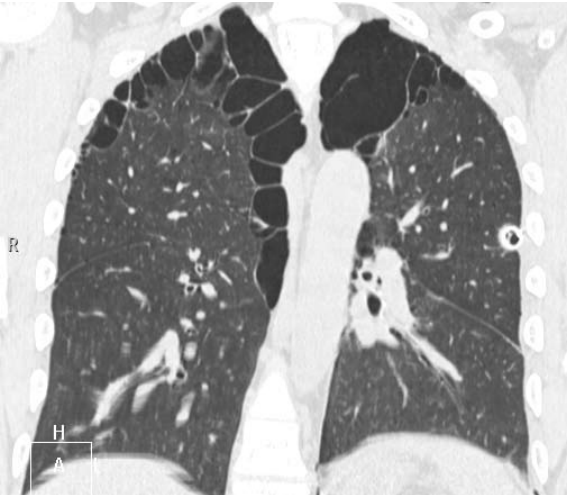
Fig. 1. Coronal reconstruction of the lung parenchyma on lung windows. Large bilateral apical and medial paraseptal bullae are present. Note the absence of any parenchymal pathology deep to the paraseptal bullae. An intercostal drain tip is seen in the left lateral pleural space.